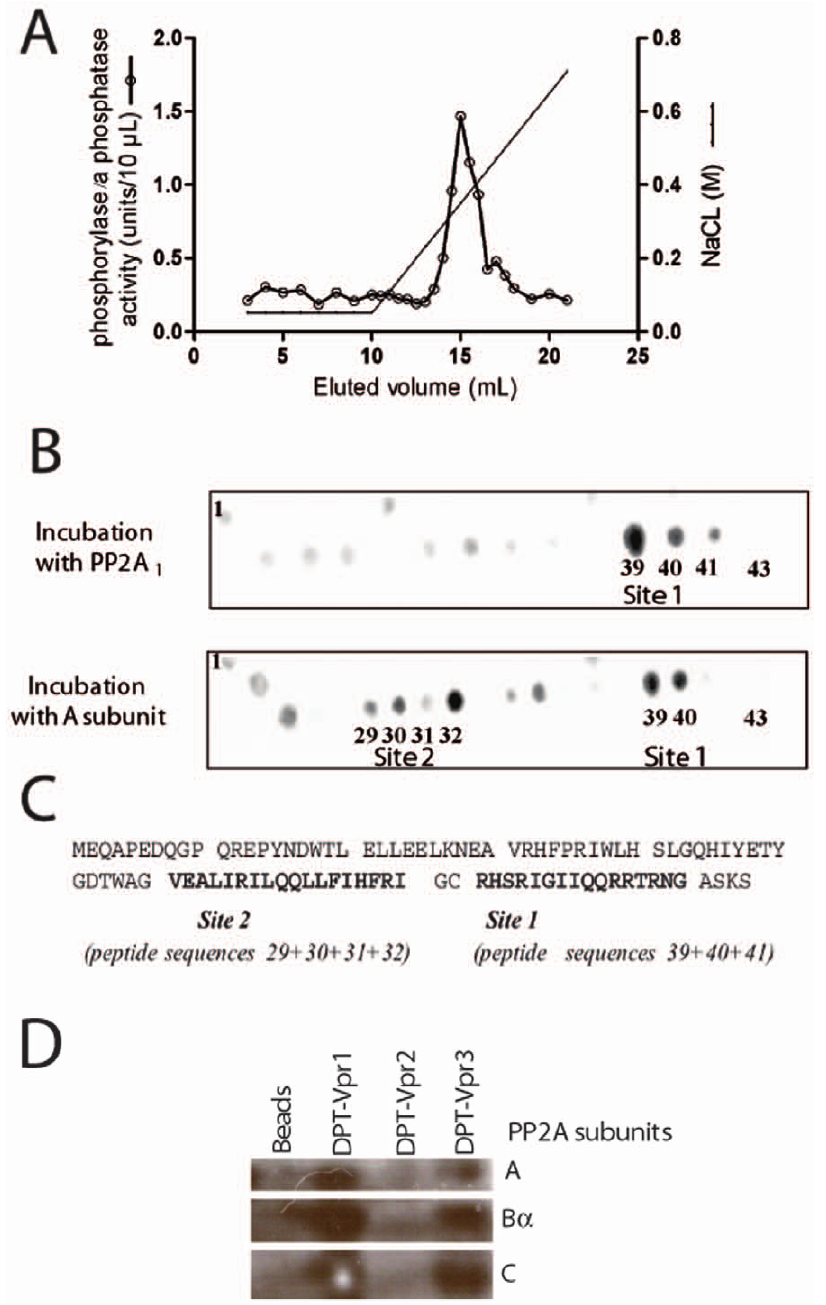
Figure 1. Analysis of HIV-1 Vpr and PP2A1 interaction. (A) 16 m g of PP2A1 holoenzyme purified from pig brain was loaded on a 1 mL HIV-1 strain 89.6-Vpr-T-agarose column equilibrated in buffer C (25 mM TrisHCl pH 7.4, 50 mM NaCl, 0.1 mM EDTA). The column was washed with 10 mL of buffer C and then developed with a 18 mL linear gradient of buffer C to buffer C plus 1 M NaCl. Phosphatase activity of collected fractions was assayed with phosphorylase a as substrat (1U =1 pm of phosphate liberated by 10 m L of fraction/min). A major peak of phosphatase activity was detected, eluting at 0.3 M NaCl. (B) ECL revelation of PP2A binding assay on cellulose-bound Vpr peptides. 43 overlapping dodecapeptides with a two-amino acid shift scanning the entire 89.6-Vpr sequence (accession number: AAA81039) were synthesized on a cellulose membrane. The membrane was incubated with PP2A1 holoenzyme (upper panel) or PP2A-A subunit (lower panel) and subsequently with anti-PP2A antibodies followed by peroxydase-labelled anti-guinea pig antibodies. (C) Sequence of HIV-1 Vpr protein: sequence of the two PP2A-A binding sites are indicated in bold. These sequences correspond to overlapping sequences of positive dodecapeptides 29 to 32 (PP2A-A subunit incubation) or 39 to 41 (PP2A1 incubation). (D) Co-precipitation of DPT-Vpr peptides with PP2A1 in HeLa cell extracts. Control magnetic beads coupled with streptavidin alone or conjugated with DPT-Vpr peptides at a concentration of 100 m M, were incubated with cells extracts (5.105 cells). Identification of bound proteins in pull-down experiments was realized by immunoblotting using antibodies against PP2A1 subunits A, B a and C.